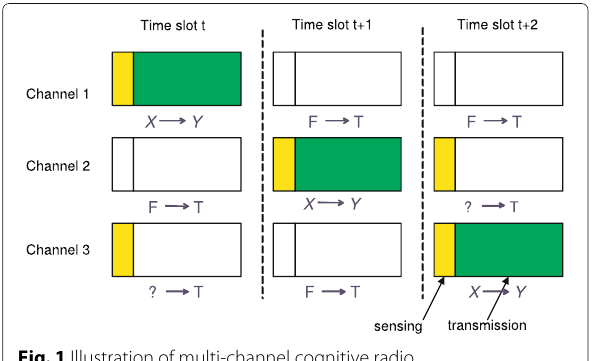
Fig. 1 Illustration of multi-channel cognitive